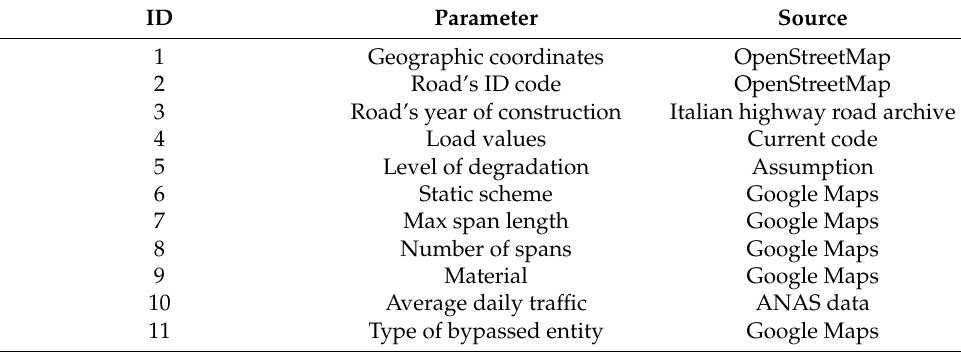
Table 3. Data for vulnerability and exposure Table 4. Parameters influencing seismic risk.